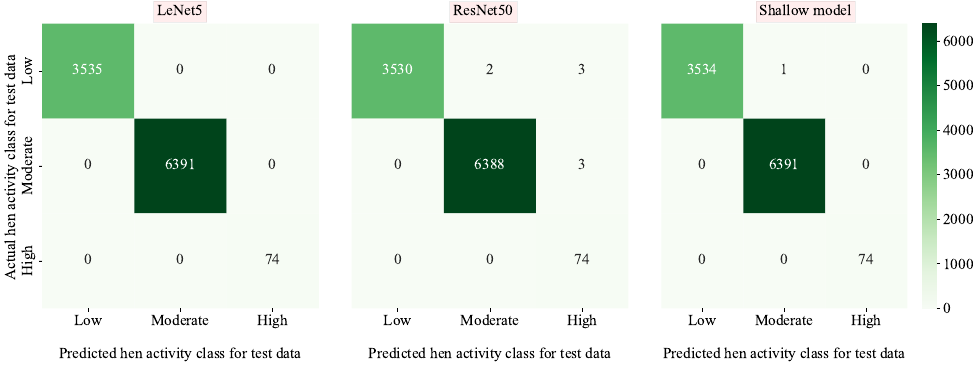
Figure 9. Accuracy (left) and loss (right) convergences during the training of the considered recogni- tion models on the green hen AVM dataset.